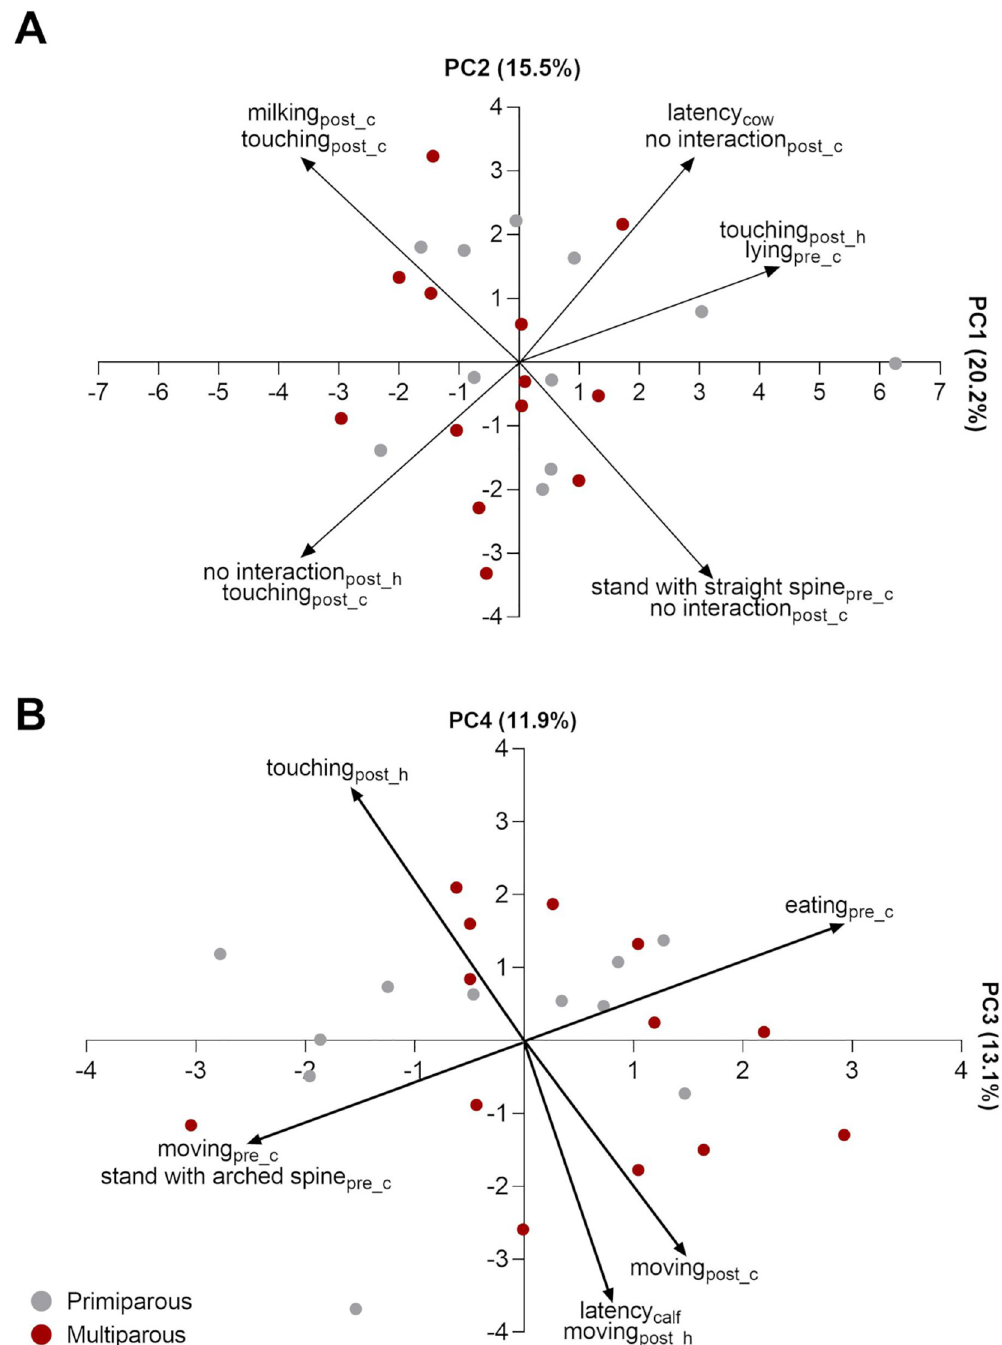
Fig 1. Plot of animals in the PC1 vs. PC2 (A) and PC3 vs. PC4 (B) extracted using behavioral data of Gyr primiparous (gray) and multiparous (red) cows at peripartum period (n = 24). Where pre_c = pre-calving, post_c = post-calving and post_h = post-handling